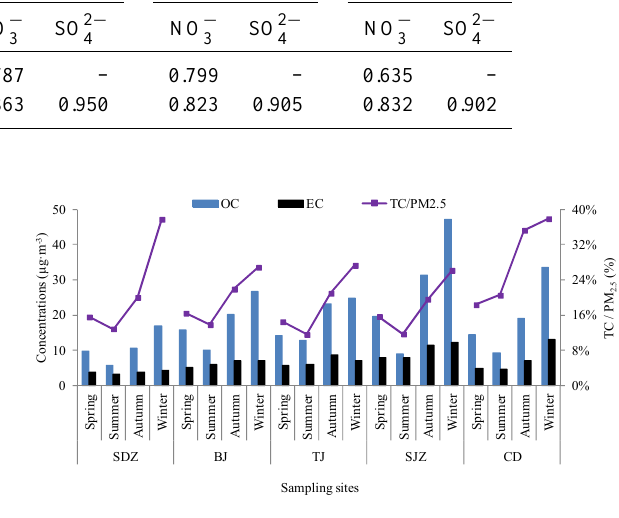
Figure 7. Average seasonal concentrations of carbonaceous components and TC/PM 2.5 Fig. 7. Average seasonal concentrations of carbonaceous compo- by study site. nents and TC/PM 2 . 5 by study